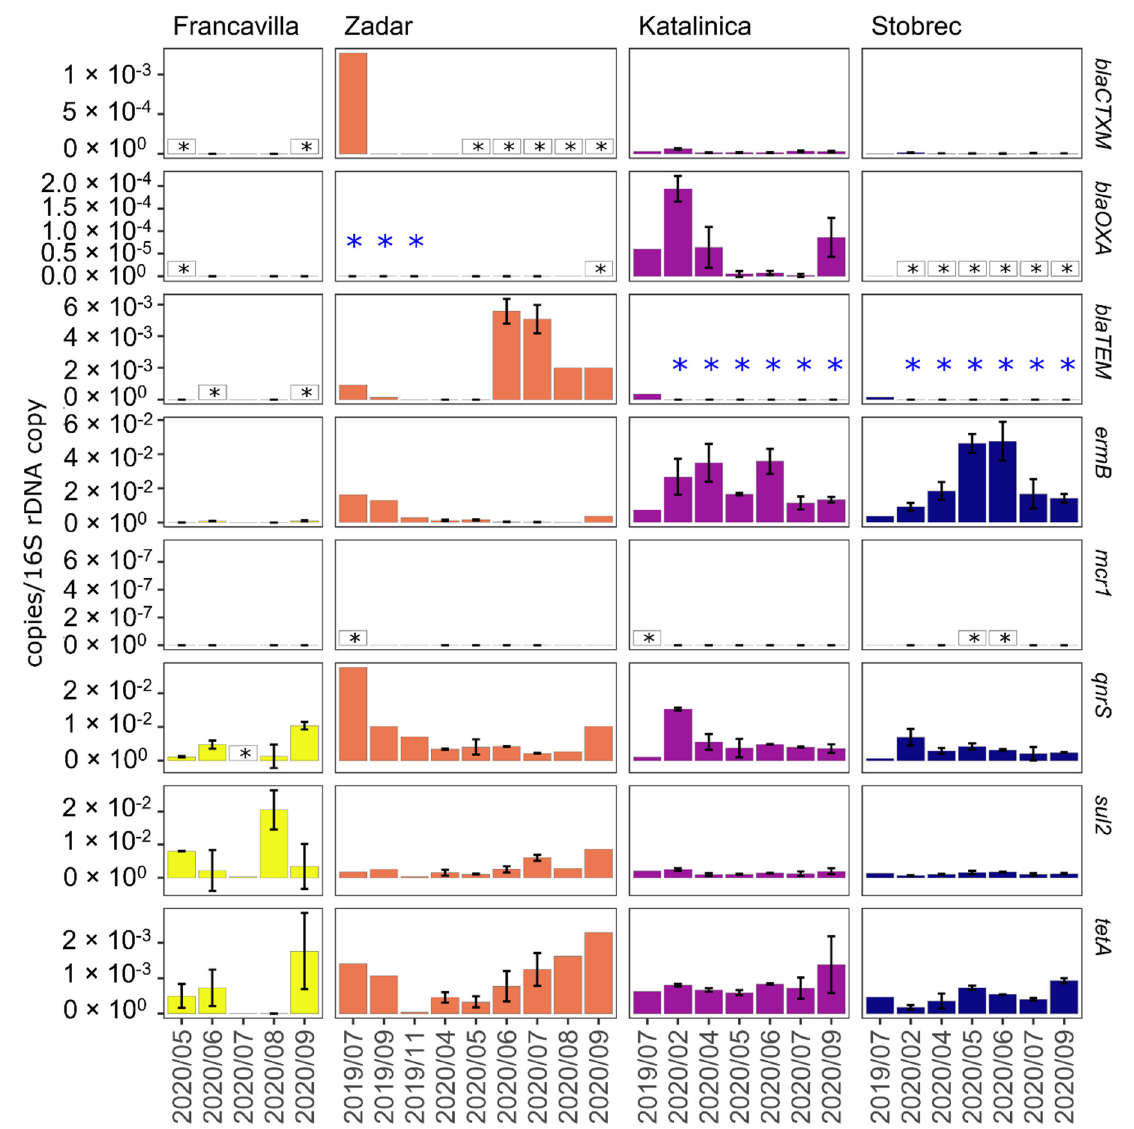
Figure 5. Content of ARGs in treated sewage samples over time. Black stars in white boxes are <LOQ values. Blue stars indicate not quantifiable samples due to primer-specificity issues. Error bars show the standard deviation between biological replicates (n = 2).